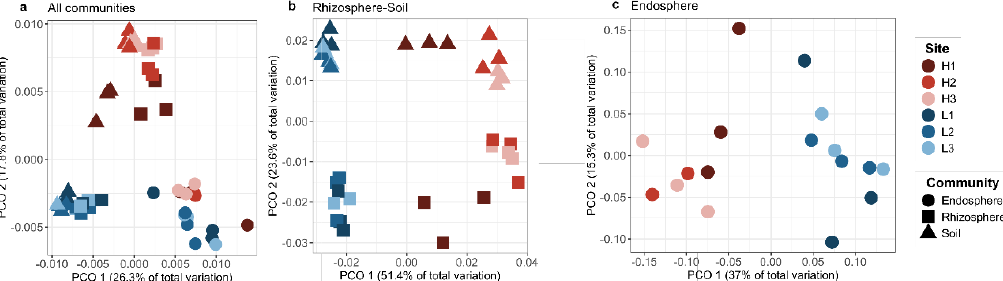
Figure 1. Principal coordinate analysis based on weighted Unifrac distances of the bacterial community inhabiting the endosphere (spheres), rhizosphere (squares) and bulk soil (triangles) ( a ). Types of communities were split in two plots to observe the e ff ect of elevation di ff erences on rhizosphere and soil ( b ) and on endosphere samples ( c ). Percentage of community variance explained by each axis is indicated in parentheses and PERMANOVA pseudo-F and p -values for elevation and compartment e ff ect are reported in the text. Symbol color indicate sites, symbols in red shades are found at high elevation and blue shade at low elevation.